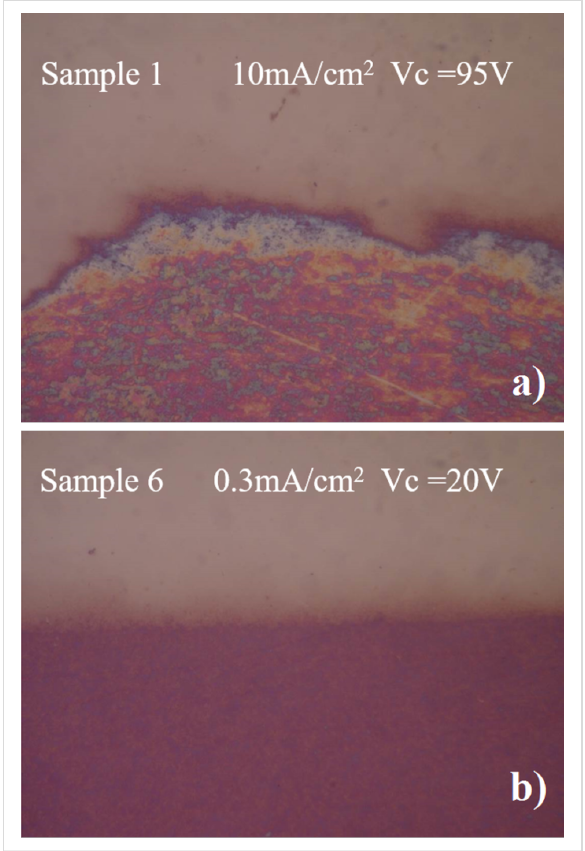
Figure 8: Optical microscopy images at 100× magnification of a) sample 1 in a) and b) sample 6. The upper part of the pictures is the NbN film, and the lower part is the oxided film after the anodization process.